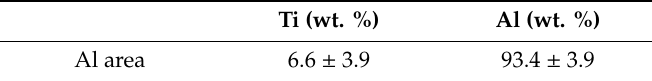
Figure 9. The XRD patterns of TiAl63 alloys annealed at 600 ◦ C for 8, 24, and 48 h. Table 3. Chemical composition of the Al area found in the microstructure annealed at 600 ◦ C for 24 h